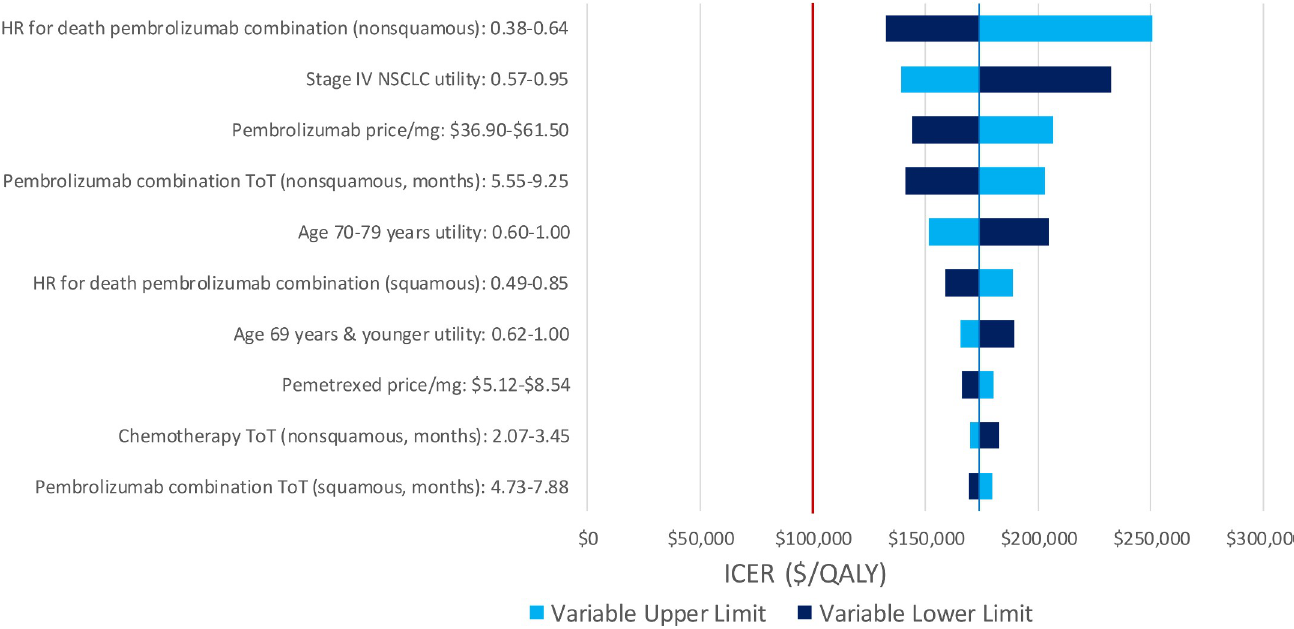
Fig 2. Deterministic sensitivity analysis for the pembrolizumab combination therapy model—pembrolizumab combination versus chemotherapy. HR, hazard ratio; NSCLC, non-small cell lung cancer; ToT, time on treatment; OS, overall survival.